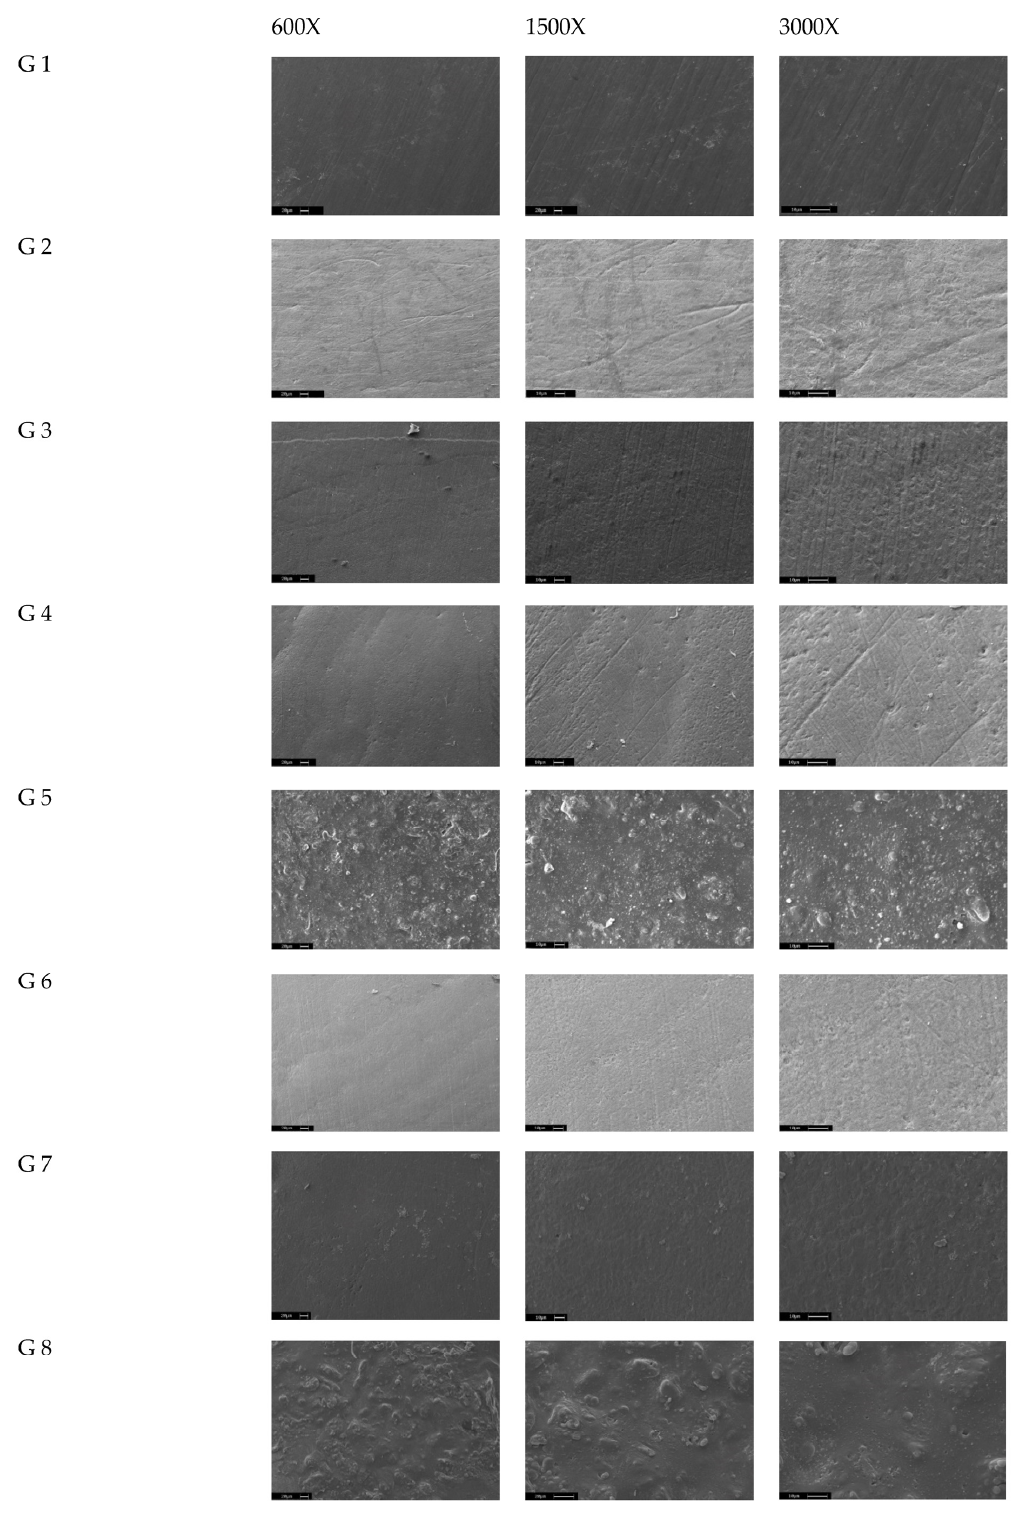
Figure 2. SEM observations divided by treatment group and magnification level—600X, 1500X and